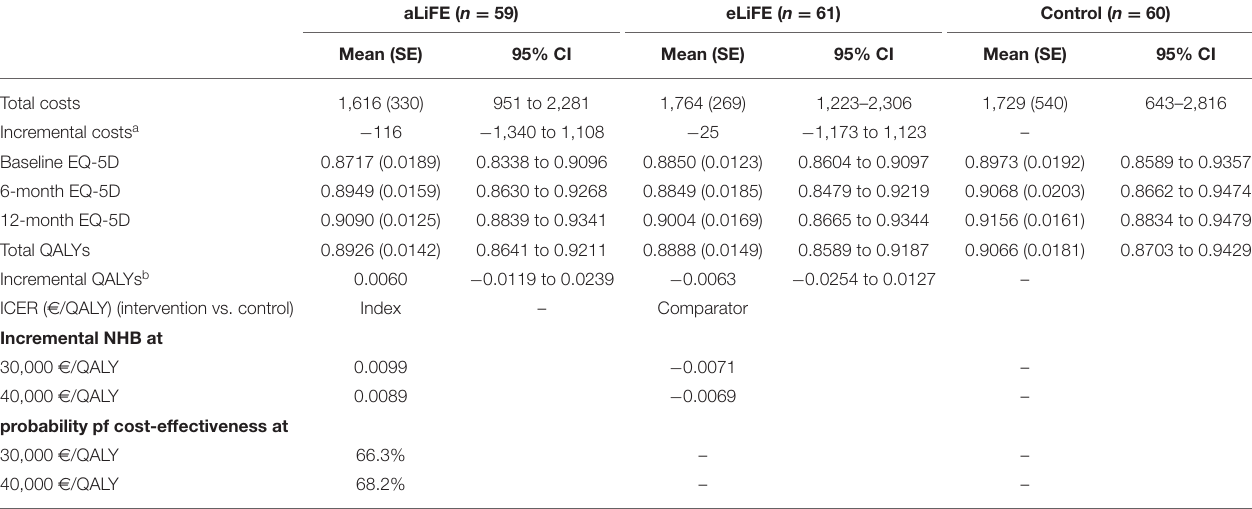
TABLE 3 | Costs, EQ-5D scores, QALYs, and cost-effectiveness